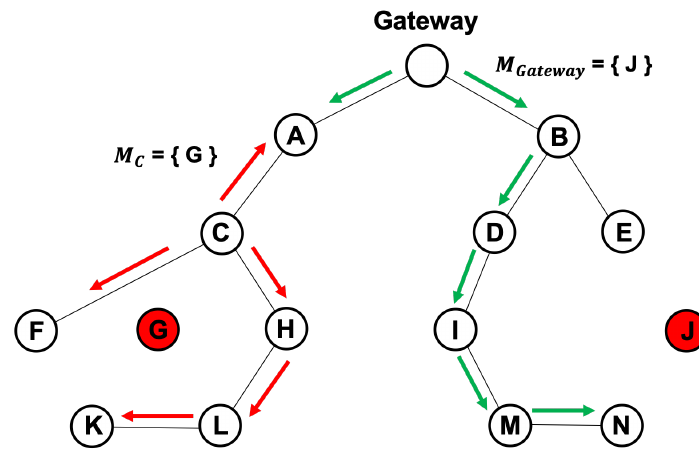
Figure 8. Example of the inspection result sharing